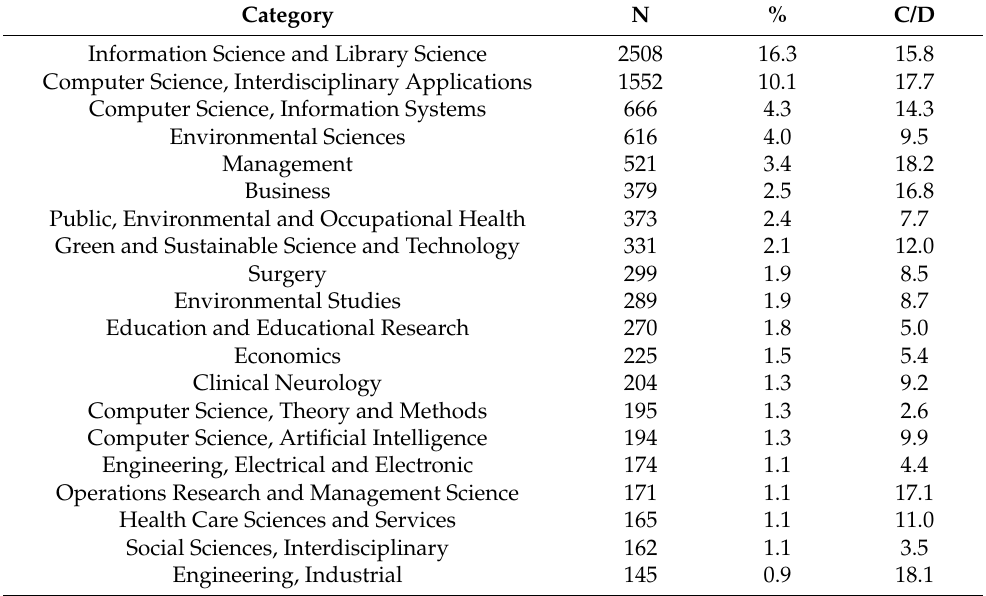
Table 4. Indexing by category according to